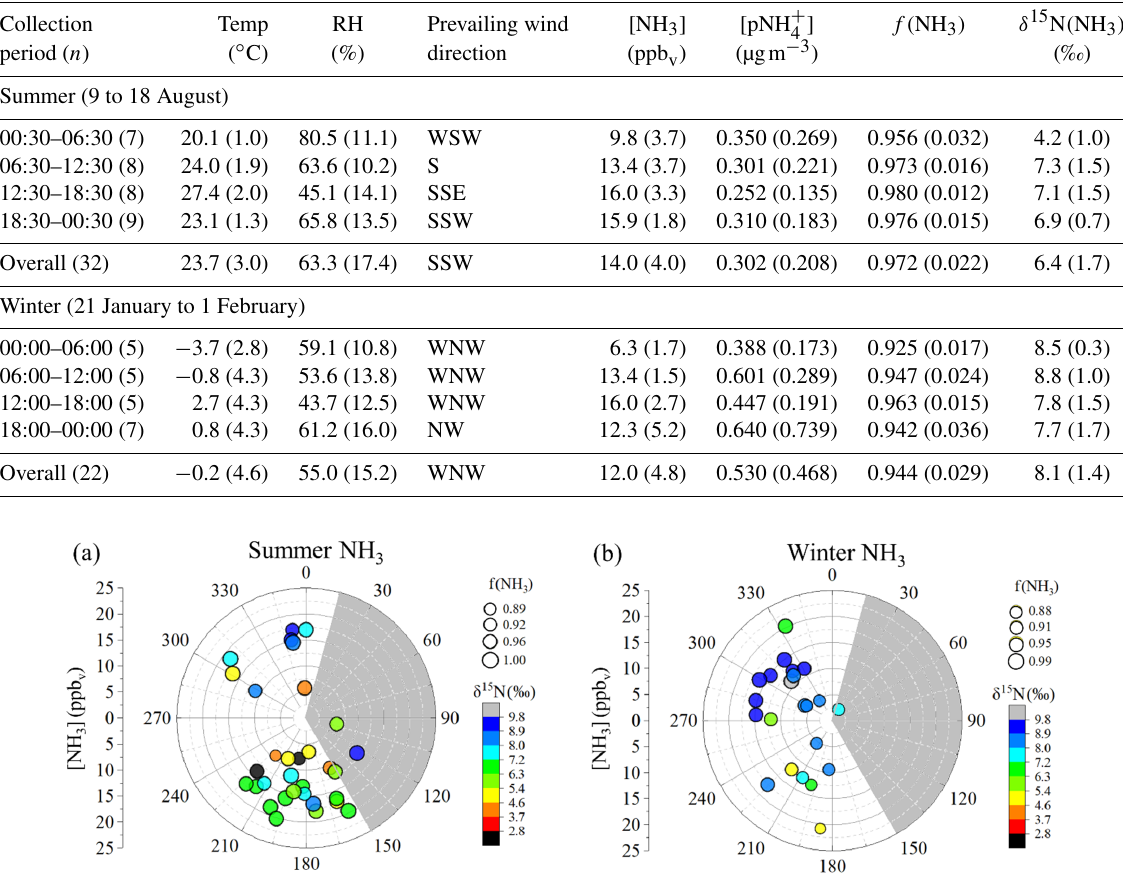
15 N ( NH ] , f ( NH 3 ) , and δ 3 ) sorted by NH x collection period (local time) for 4